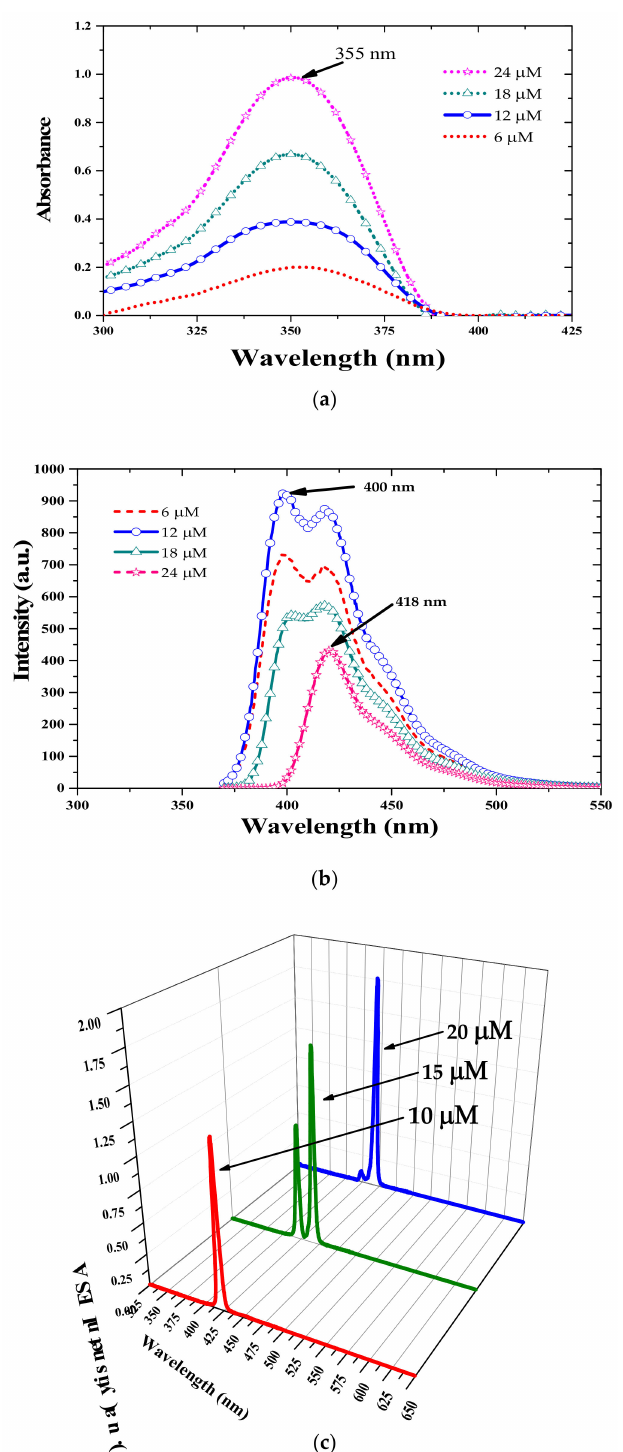
Figure 6. ( a ) Absorption and ( b ) fluorescence spectra of HOTF oligomer in benzene at concentrations ranging from 6 to 24 µ M. ( c ) ASE forms pure oligomer in benzene at concentrations of 10, 15, and 20 µ